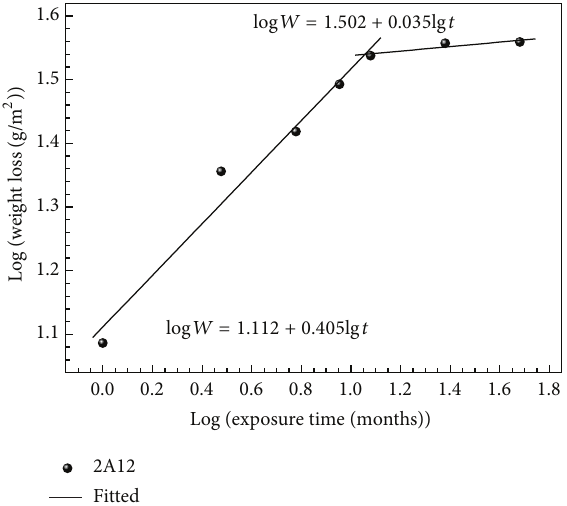
Figure15:BilogarithmicplotsofdatapointsfromFigure 3(a)aswell as the fitting